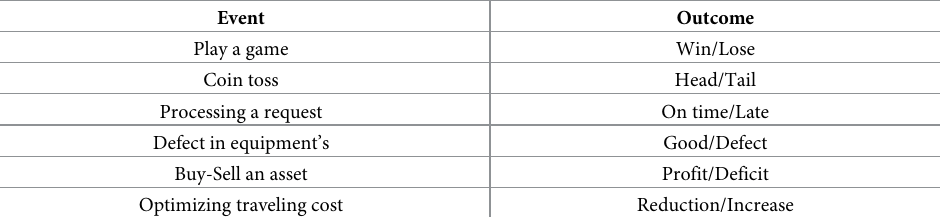
Table 9. Examples of random events and the respective binary